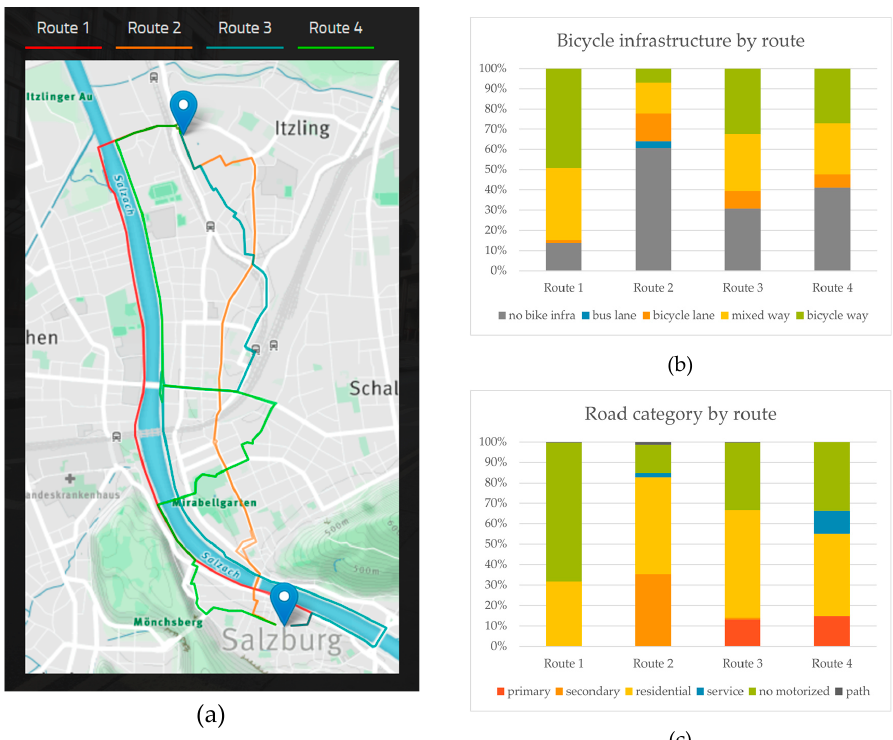
Figure 1. Overview of pre-defined routes for the case study. (a) Screenshot of web-map displaying all four routes connecting Science City (North) with the city centre (South); (b) Share of different bicycle infrastructure types per route; (c) Share of road categories involved in each route.